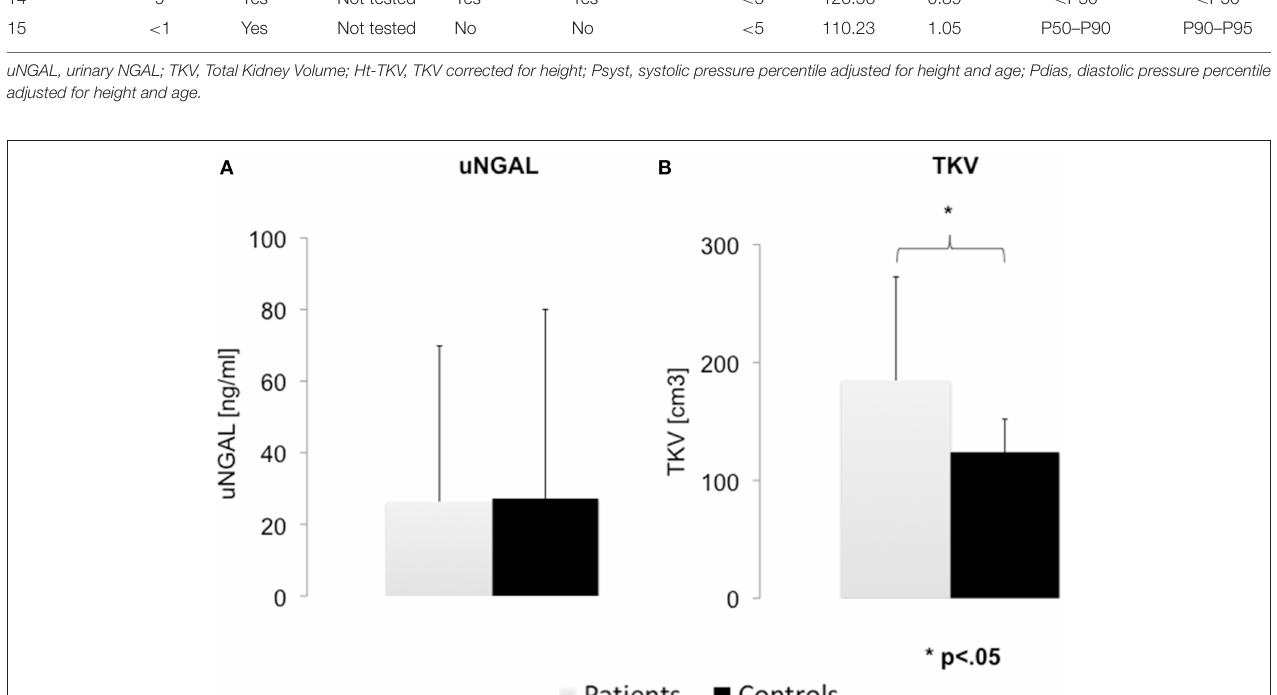
[ χ 2 (2, N = 30) = 1.08, P = 0.58] were observed between the two